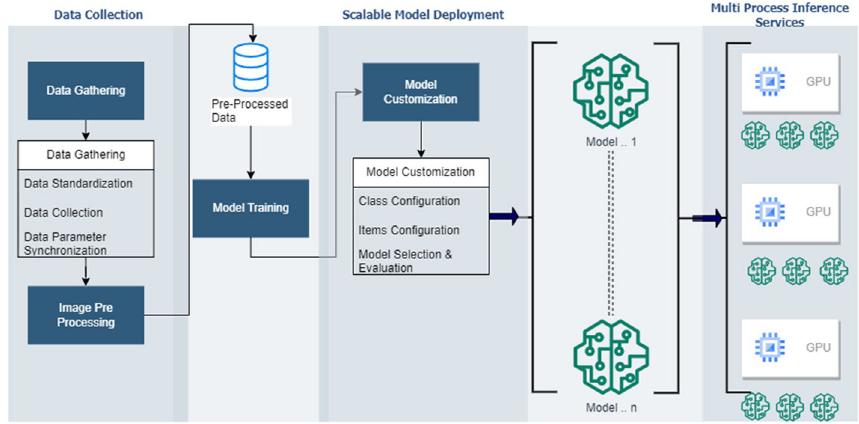
Fig. 1 Proposed framework